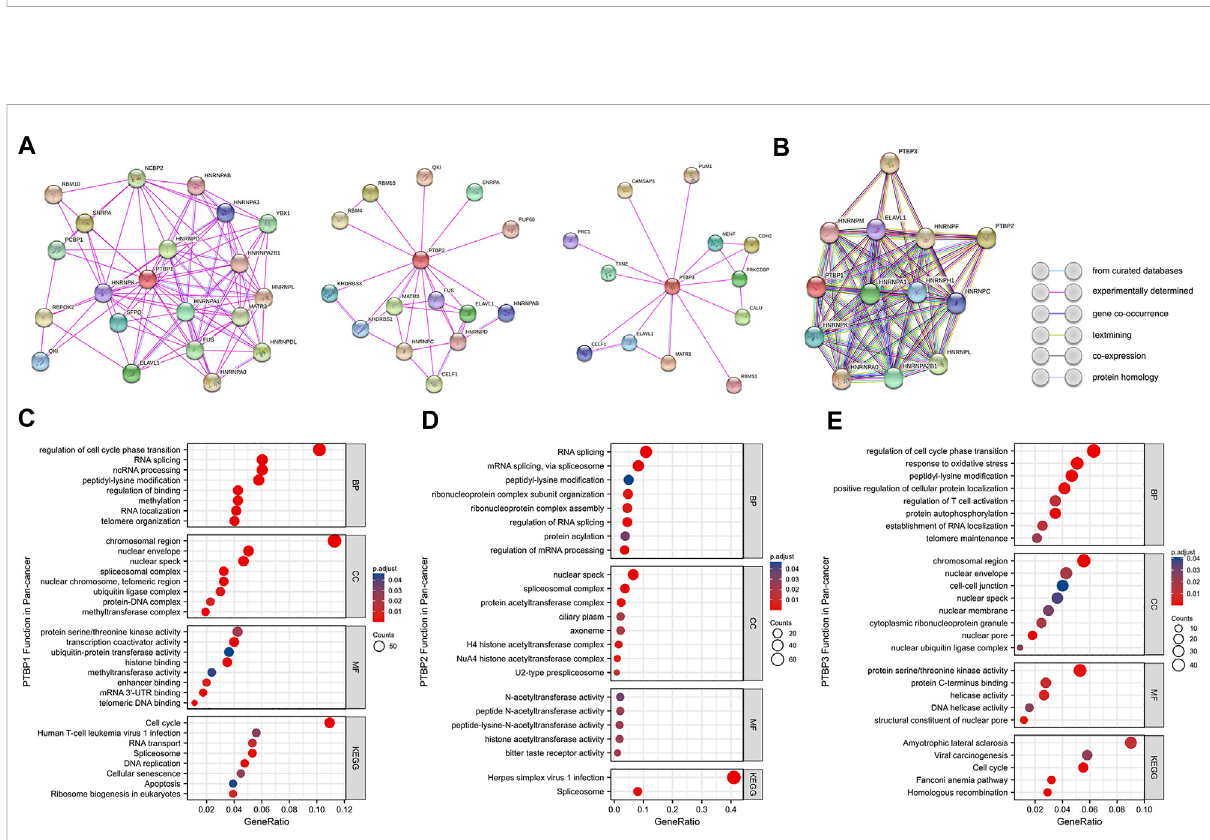
FIGURE 9 Protein-protein interaction networks and functional enrichment analysis of PTBPs in pan-cancer. (A) Experimentally validated interacting proteins of PTBPs using STRING. (B) The interaction relationship among the three protein molecules. Line colors in the legend indicate different relationships. (C – E) GO enrichment and KEGG pathway analysis results for co-expressed mRNAs of PTBPs